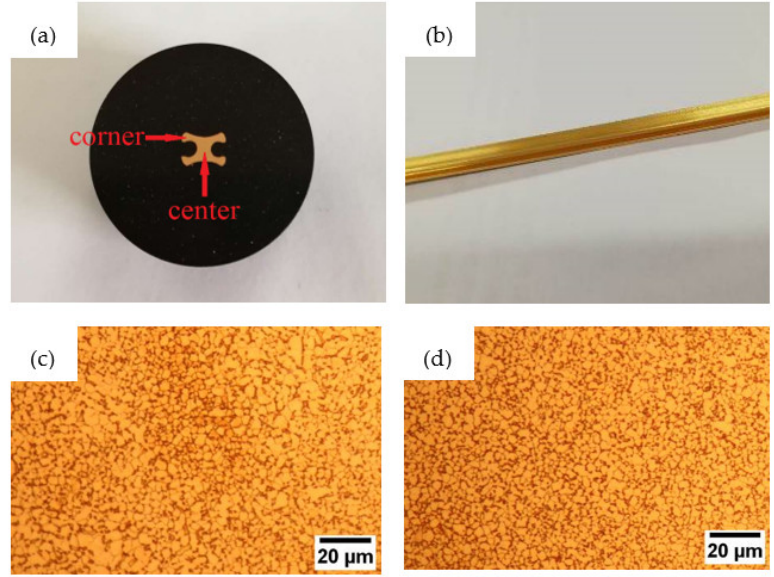
Figure 12. H-shaped brass wire product ( a ) section; ( b ) overall; ( c ) refined grain in center; ( d ) refined grain in corner.